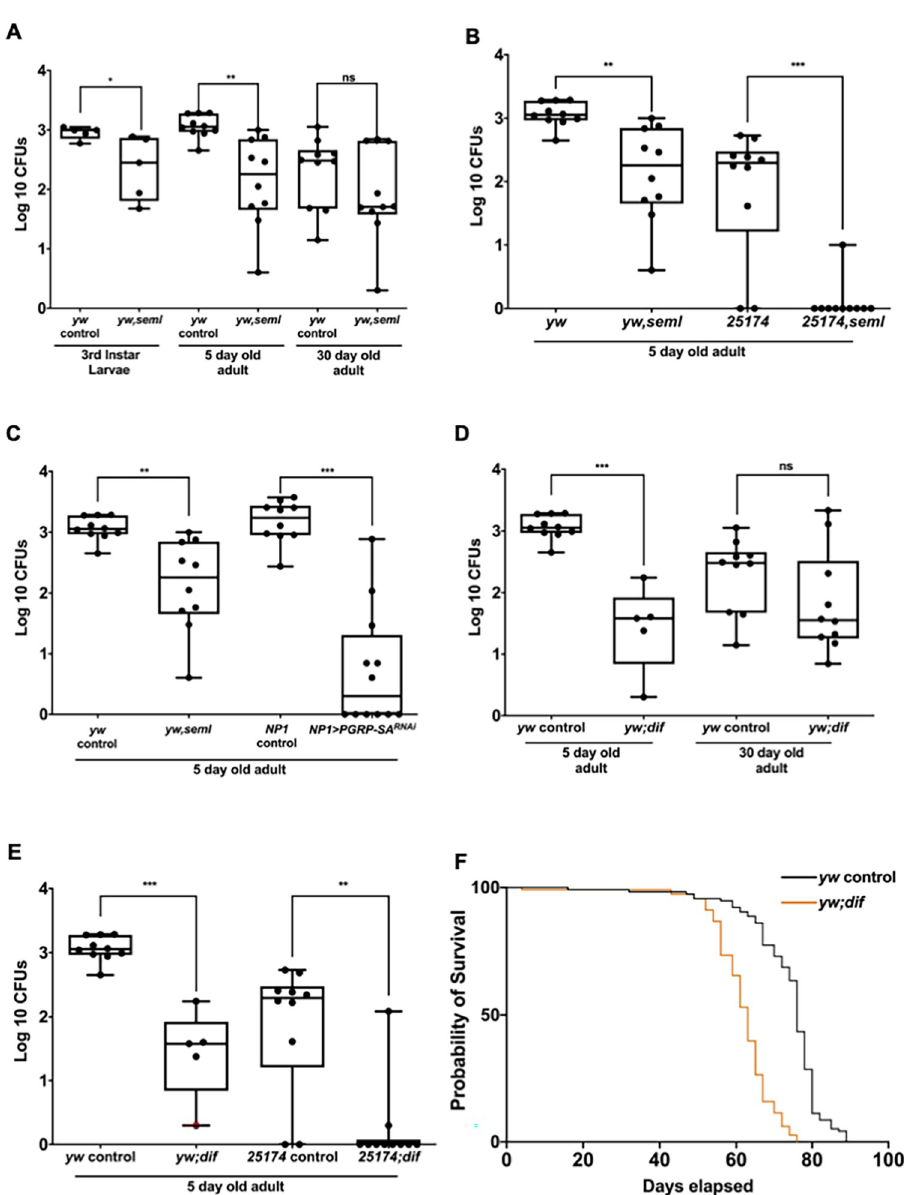
Fig 1. Loss of the host receptor for bacteria PGRP-SA or the NF- κ B homologue DIF reduces cultivable bacterial density in the gut. (A) Larvae and 5-day old adults deficient for PGRP-SA have a significantly reduced density of cultivable bacteria while this is not the case for older PGRP-SA seml mutant flies (30-day old) flies. (B) This was not an effect of the genetic background as 5-day old PGRP-SA seml mutant flies in a DGRP line 25174 background also displayed reduced cultivable bacterial load. (C) The requirement for PGRP-SA was in enterocytes (ECs) as RNAi of PGRP-SA via the EC-specific NP1-GAL4 driver resulted in a significantly reduced cultivable bacteria load. (D) The Drosophila NF- κ B ortholog DIF, downstream of PGRP-SA and the Toll receptor, was also important for the maintenance of bacterial density. (E) Enteric CFU reduction was not dependent on the genetic background since, as their age-matched yw; dif counterparts, the 25174; dif flies had also significantly reduced bacterial density. (F) The yw; dif flies had a reduced lifespan. Each dot represents one gut (n = 15 for both larvae and each adult category) in experiments done in three independent experiments (each experiment with n = 5). The log10 CFU values of mutants and controls were statistically compared using student’s t-test (ns = not significant, � p < 0.05, �� p < 0.01, ��� p < 0.001, ���� p < 0.0001).